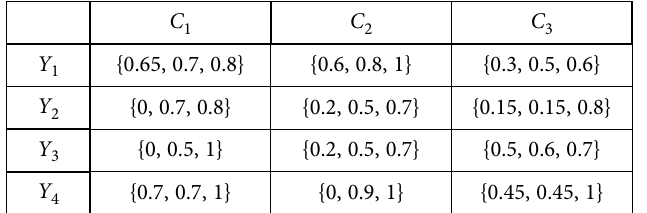
Table 7. Hesitant fuzzy decision